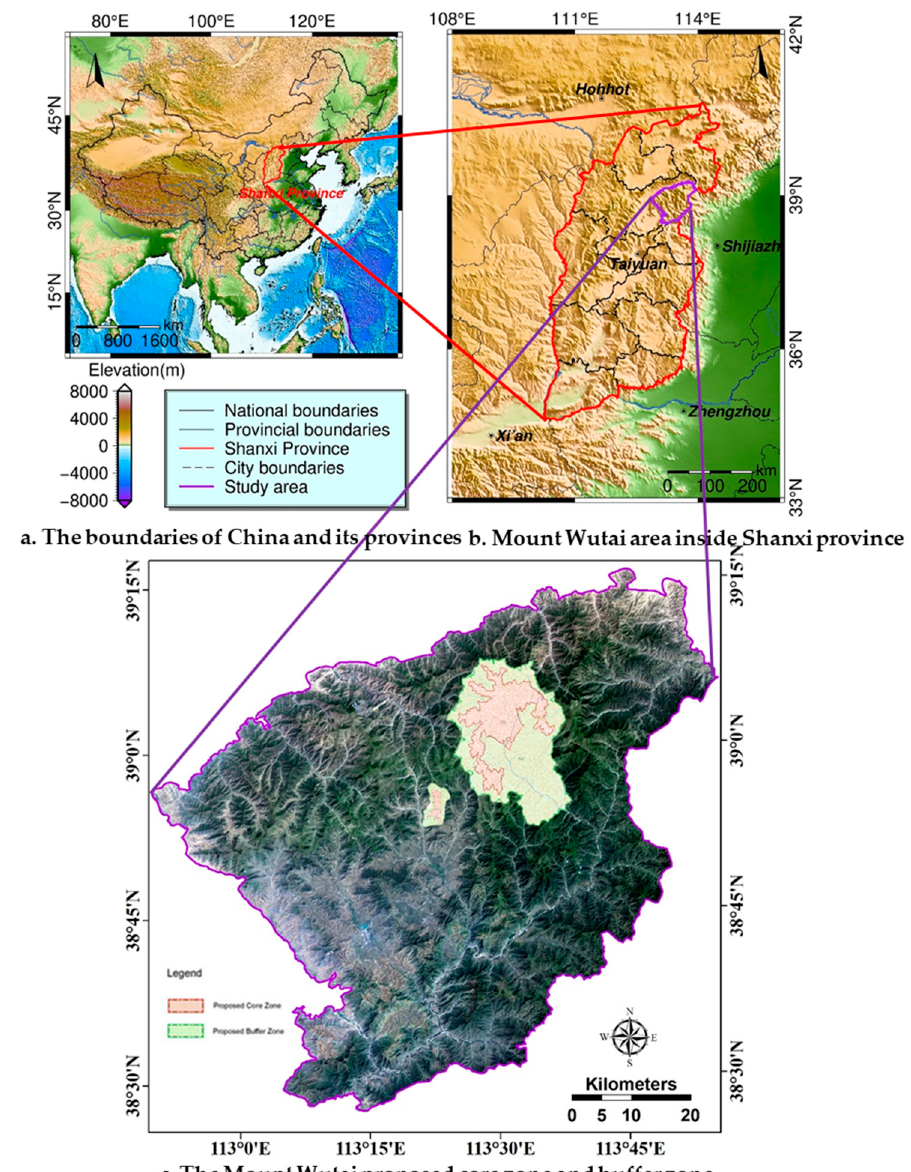
Figure 1. Mount Wutai and the research area.